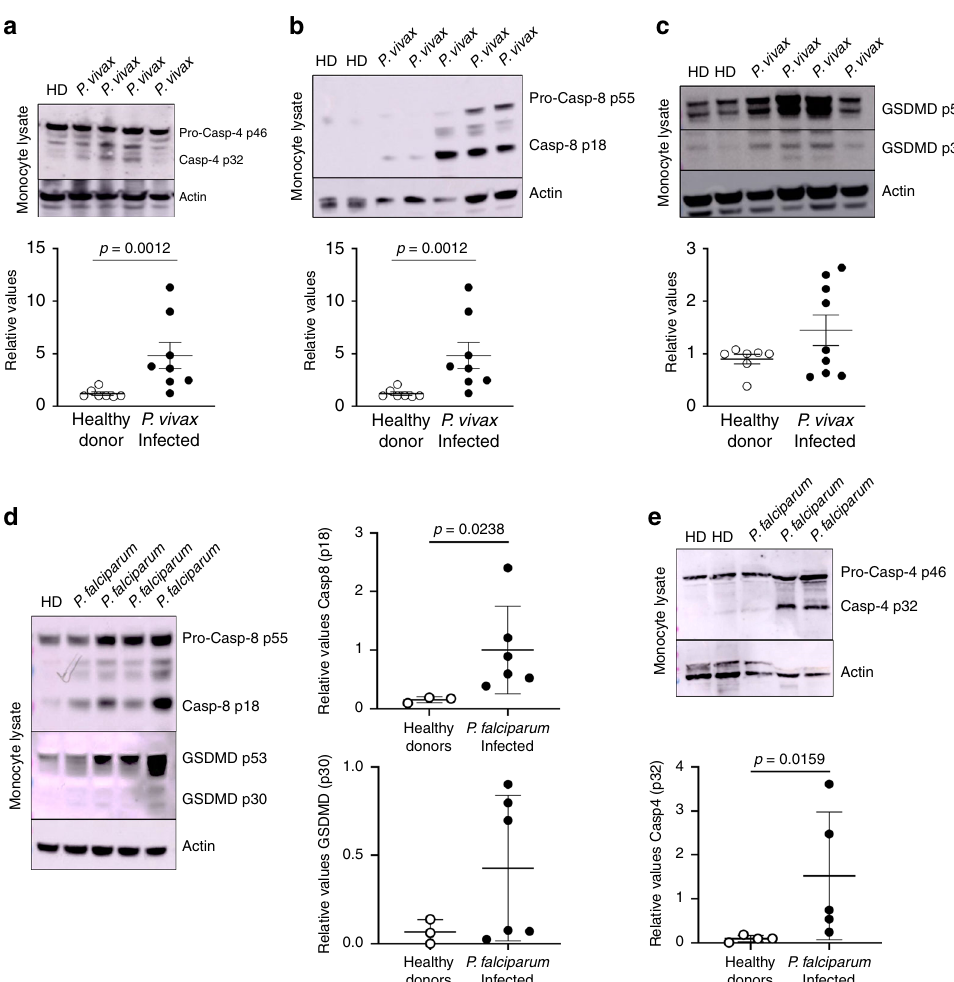
Fig. 7 Activation of caspases-4 and -8 in monocytes from malaria patients. CD14 + monocytes were isolated from peripheral blood mononuclear cells (PBMCs) from healthy donors (HD) and malaria patients ( P. vivax ), lysed with RIPA buffer and analyzed by western blot. a Western blot was performed with an anti-caspase-4 antibody. The levels of caspase-4 p32 expression were analyzed by densitometry and shown in the bottom panel (HD n = 7 and P. vivax n = 8). b Western blot was performed with CD14 + monocytes lysates from two HD and fi ve P. vivax malaria patients, and expression of caspase-8 (p55) and cleaved caspase-8 (p18) detected using an anti-caspase-8 antibody. The levels of caspase-8 p18 expression were analyzed by densitometry and shown in the bottom panel (HD n = 4 and P. vivax n = 9). c Western blot was performed with CD14 + monocytes lysates from HD as well as P. vivax malaria patients and revealed with an anti-GSDM-D antibody. The levels of cleaved GSDM-D p30 expression were analyzed by densitometry and shown in the bottom panel (HD n = 7 and P. vivax n = 9). d CD14 + monocytes lysate isolated from healthy donors (HD) and malaria patients ( P. falciparum ) were analyzed by western blot performed against caspase-8 and GSDM-D. The levels of caspase-8 and GSDM-D expression were analyzed by densitometry and shown in the side panels (HD n = 3 and P. falciparum n = 6). e CD14 + monocytes lysate isolated from healthy donors (HD) and malaria patients ( P. falciparum ) were analyzed by western blot performed against caspase-4. The levels of caspase-4 expression were analyzed by densitometry and shown in the bottom panel (HD n = 4 and P. falciparum n = 5). Statistical analysis was performed by two-tailed unpaired Mann – Whitney test at 95%